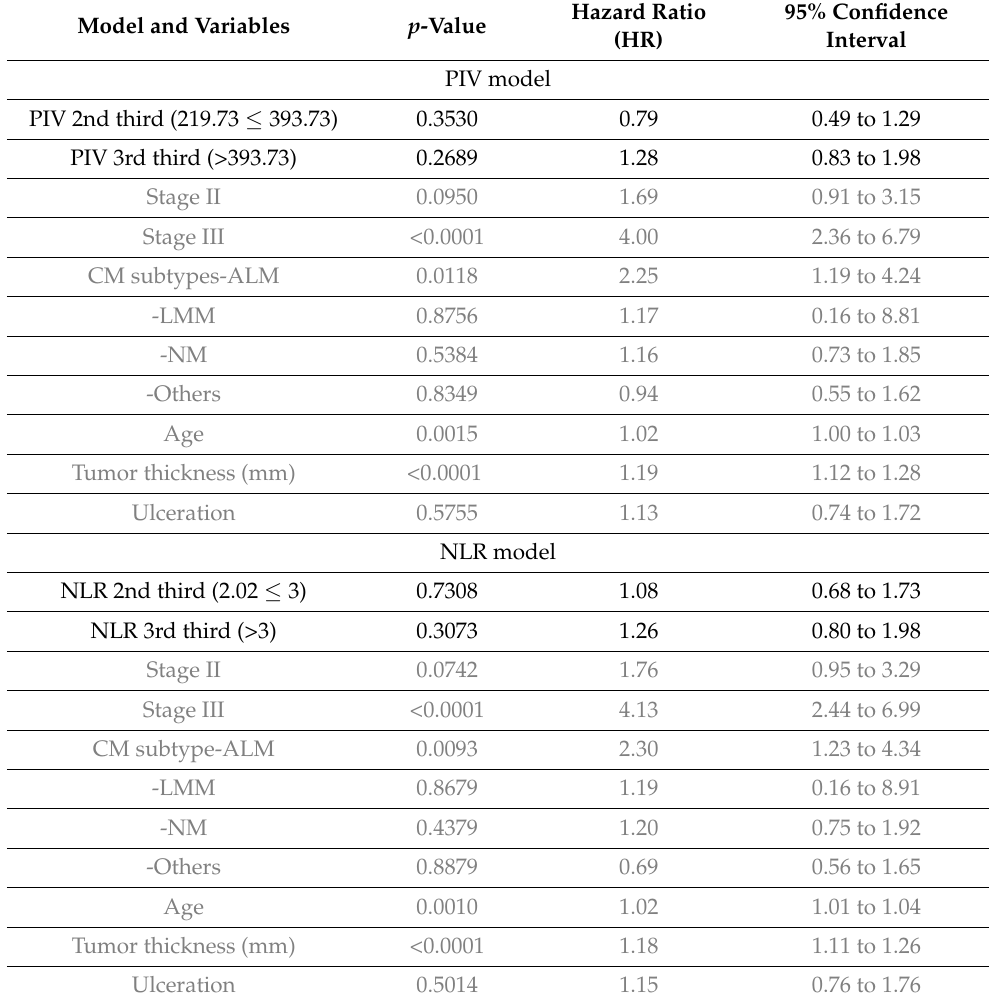
Table 2. Cox proportional hazards regression model for cutaneous melanoma (CM) relapse-free survival and the total effects for the pan-immune-inflammation value (PIV) and neutrophil-to- lymphocyte ratio (NLR) adjusted for potential confounders. Model and